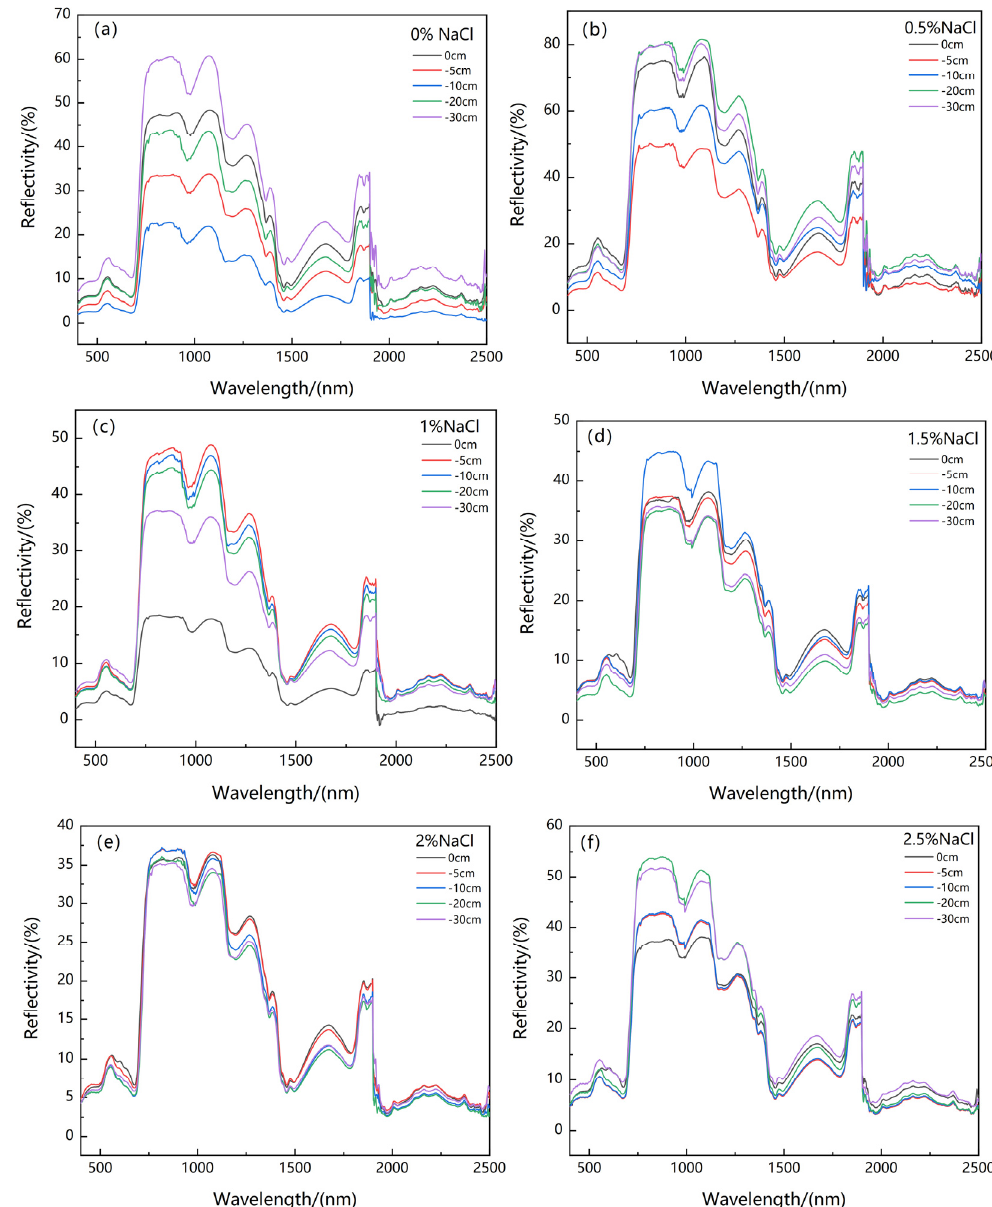
Figure 6. The change of reflectance spectrum under five groundwater levels (0 cm, − 5 cm, − 10 cm, − 20 cm, and − 30 cm) and six NaCl salt concentrations (0% ( a ), 0.5% ( b ), 1% ( c ), 1.5% ( d ), 2% ( e ), and 2.5% ( f ))3.2.1. Analysis of the Response of First-Order Differential Spectrum of Suaeda salsa Canopy to Water and Salt Stress